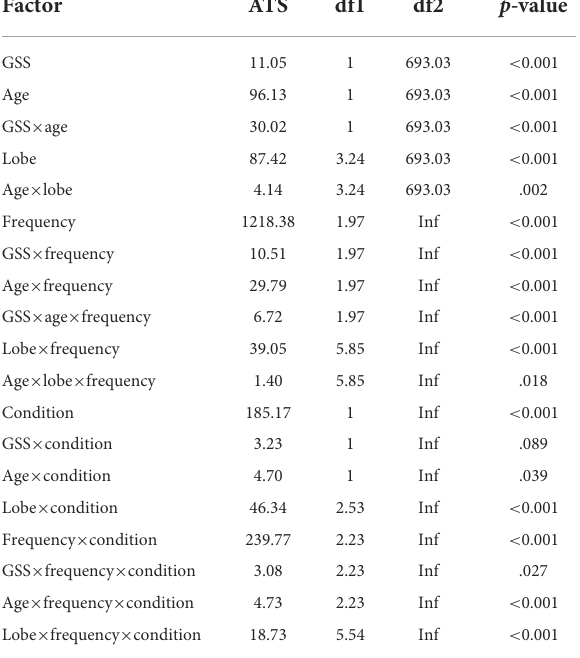
TABLE 3 ANOVA-type semi-parametric analysis of variance with parametric bootstrap on EEG measures for factors condition (within: rest vs. after mood induction), seasonality (between: GSS low vs. high), age (between: young vs. old), hemisphere (within: left vs. right), lobe (within: frontal, central, temporal, parietal, occipital), frequency (within: delta, theta, alpha, beta).